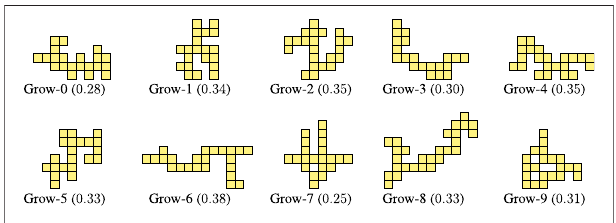
FIGURE 9 | Morphologies generated with the Grow procedure together with the corresponding value of criticality.